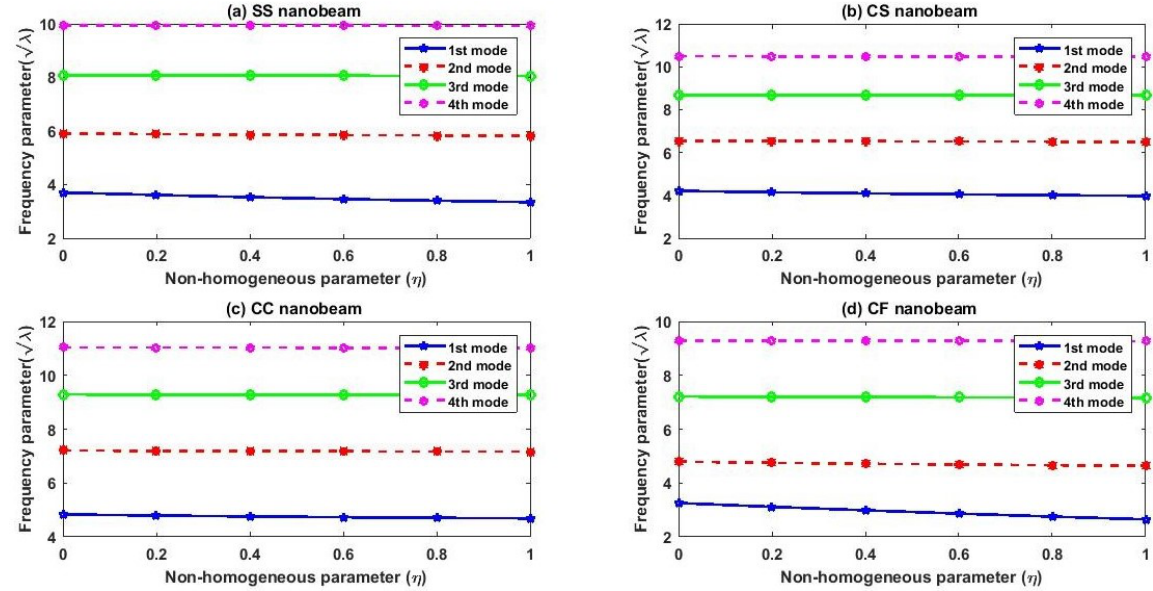
Figure 3: Variation of frequency parameter with non-uniform or non-homogeneous parameter Table 14: Frequency parameter uniform parameter